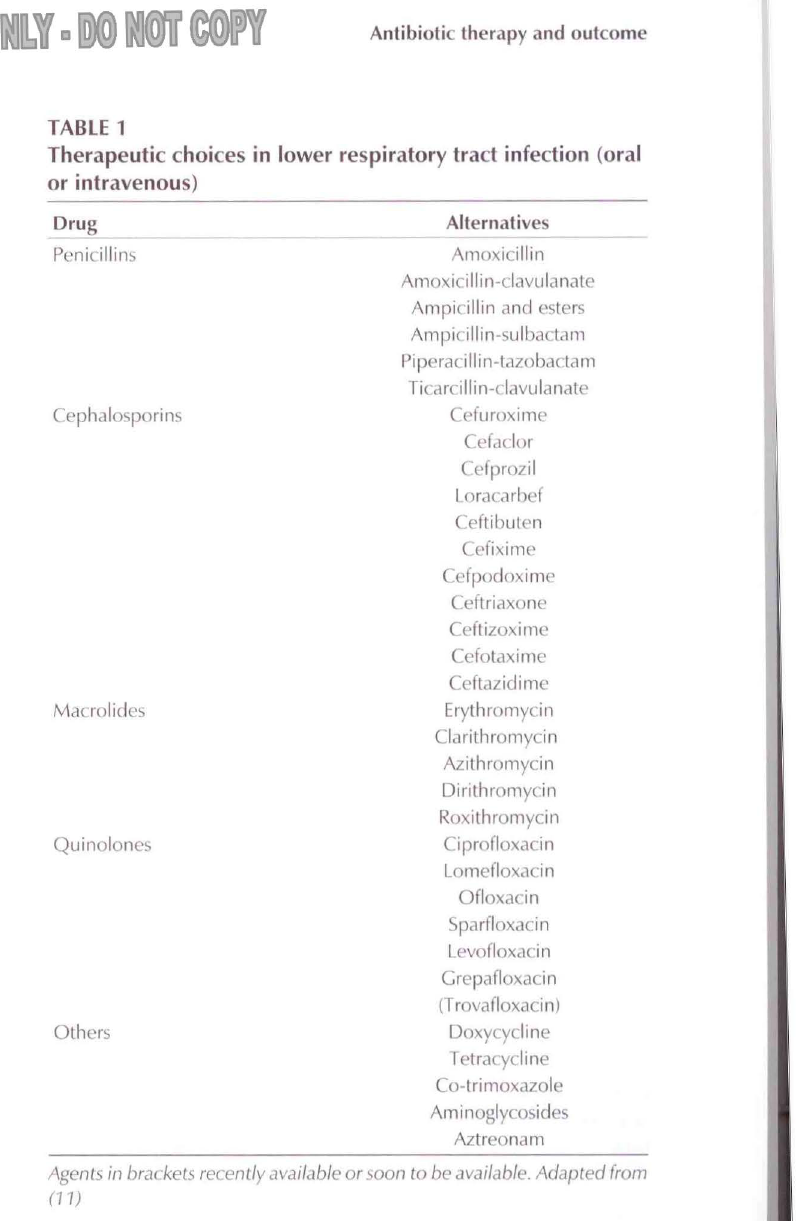
Therapeutic choices in lower respiratory tract infection (oral or